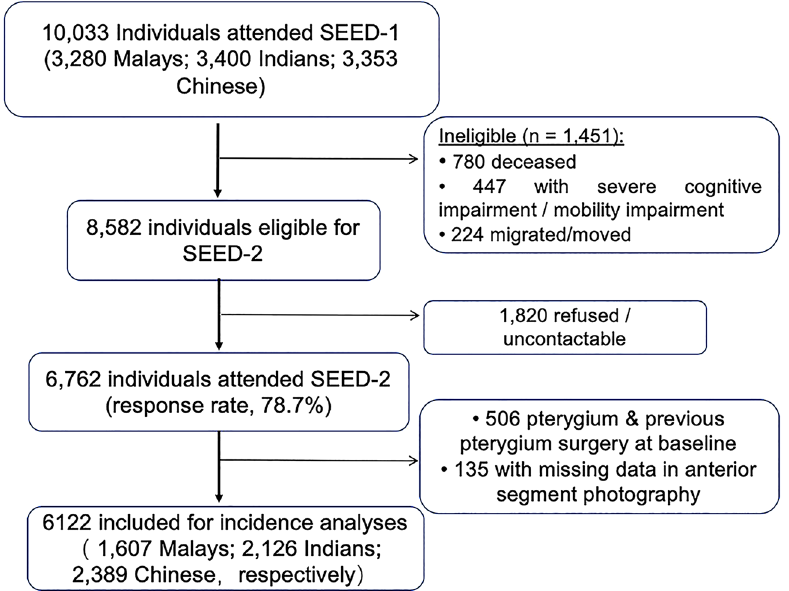
Figure 1. Flow chart that illustrates the subject selection process for this